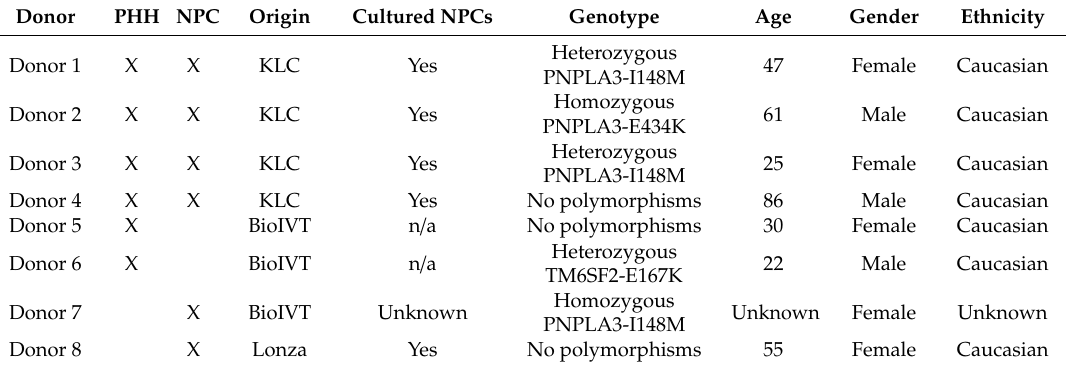
Table 1. Primary human hepatocyte and non-parenchymal cell